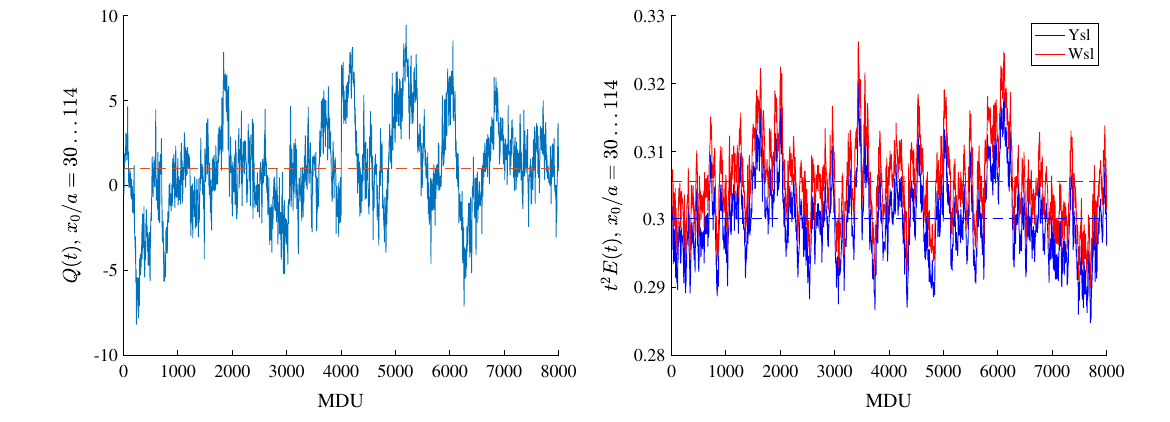
Fig. 4 Histories of the topological charge Q ( t ) (left) and of t 2 E ( t ) (right) of the lattice with the finest lattice spacing (both replica of ensemble B), where t corresponds approximately to t 0 . The two curves showtheresultsfordifferentdiscretizationsof E ( t ) ,symmetric“clover”